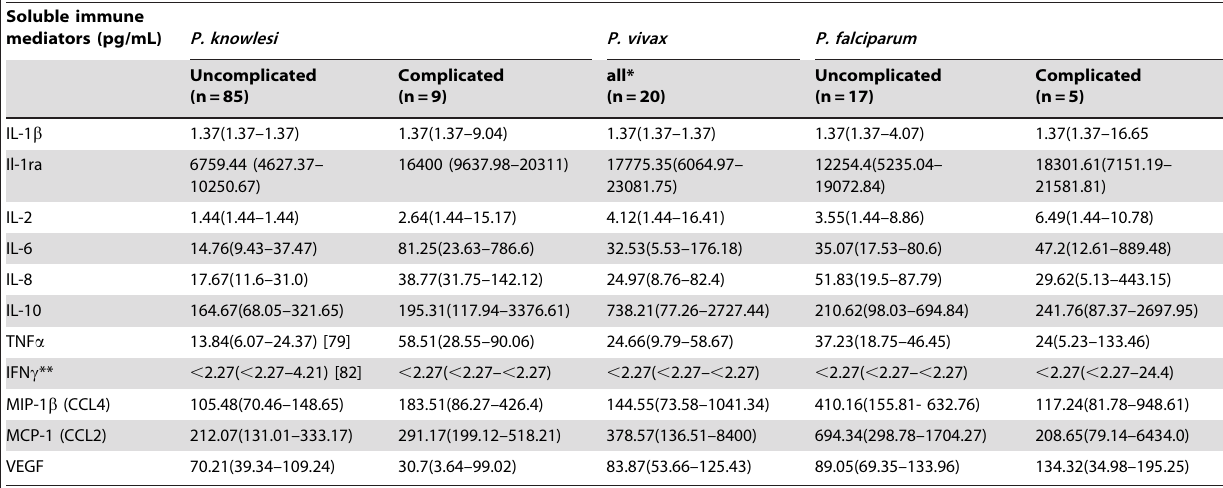
Table 2. Cytokine and chemokine results summarised by patient group. Soluble immune mediators